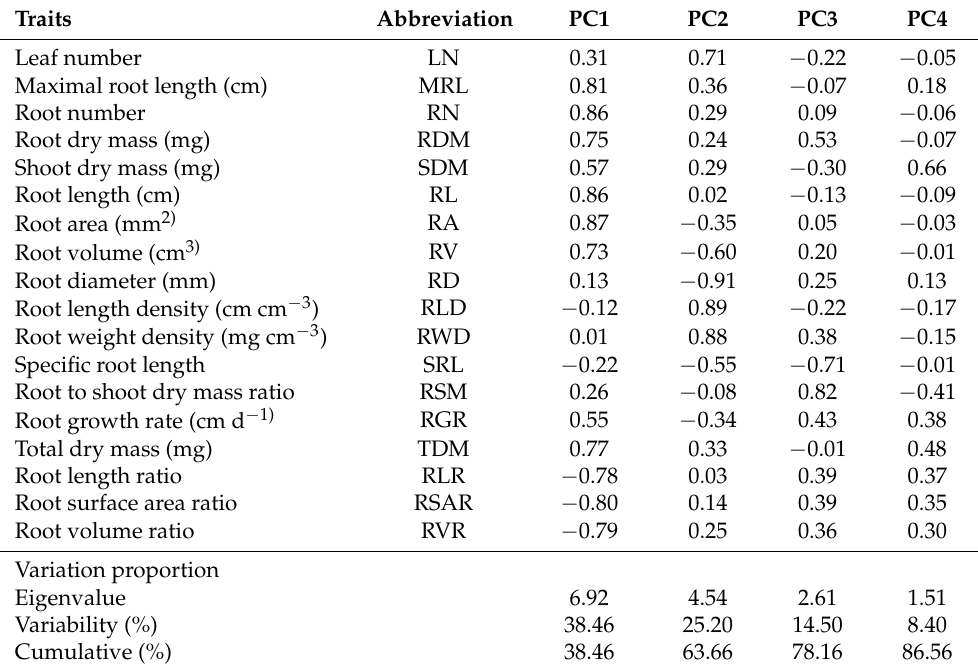
Table 3. Principal component analysis (PCA) of 18 selected traits in 65 millet genotypes ( p < 0.05, CV ≥